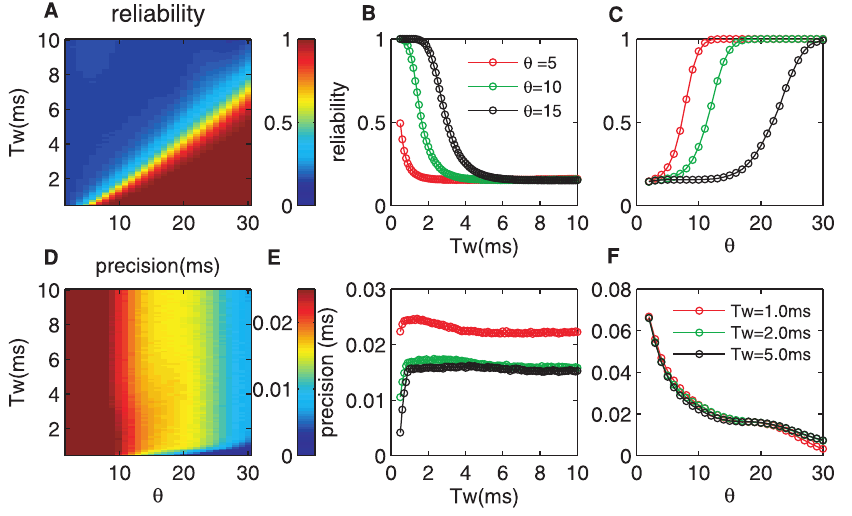
Figure 3. Influences of the detection time window T w and the threshold h of the CD neuron on the detection reliability and precision. (A) The reliability as a function of T w and h . Note that there exits a clear boundary for high and low reliability. Almost 100 % detection reliability can be achieved for proper pairing of T w and h . (B, C) Detailed views of parts of (A) with different h ~ 5 , 10 , 15 and T w ~ 1 : 0 , 2 : 0 , 5 : 0 ms, respectively. (D) The detection precision as a function of T w and h . (E, F) Detailed views of parts of (D). It is clear that h has a significant effect on the precision for any time windows. The parameters are V th ~{ 40 mV, V r ~{ 65 mV, t m ~ 10 ms, and D ~ 20 mV/ms.